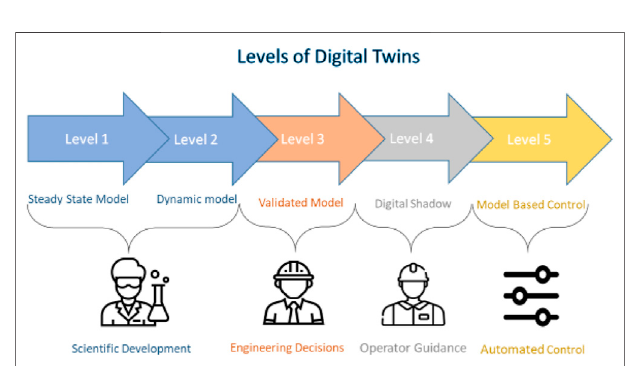
FIGURE 2 | fi ve levels of Digital Twins in process operations (Udugama et al., 2021).